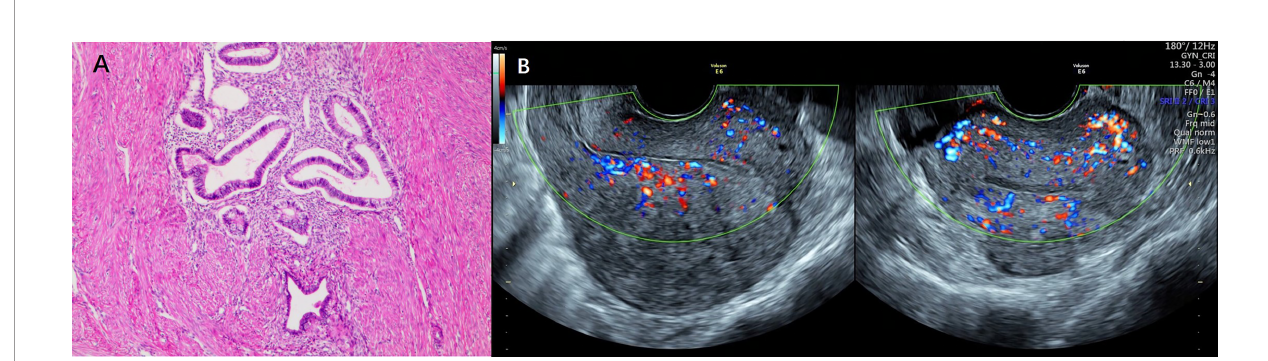
FIGURE 2 | Representative photographs of adenomyosis diagnosed by histology and transvaginal ultrasound. (A) Representative photographs of adenomyosis diagnosed by histology. Endometrial glands and stroma exist in the myometrium, accompanied by compensatory proliferation and hypertrophy of surrounding